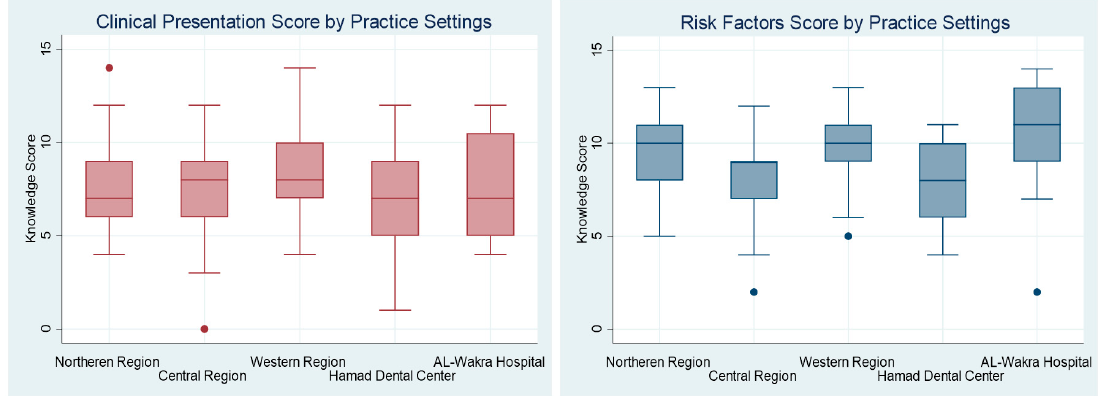
Figure 1. Score for knowledge of the clinical presentation of and risk factors for oral cancer by the five practice settings ( n = 177).